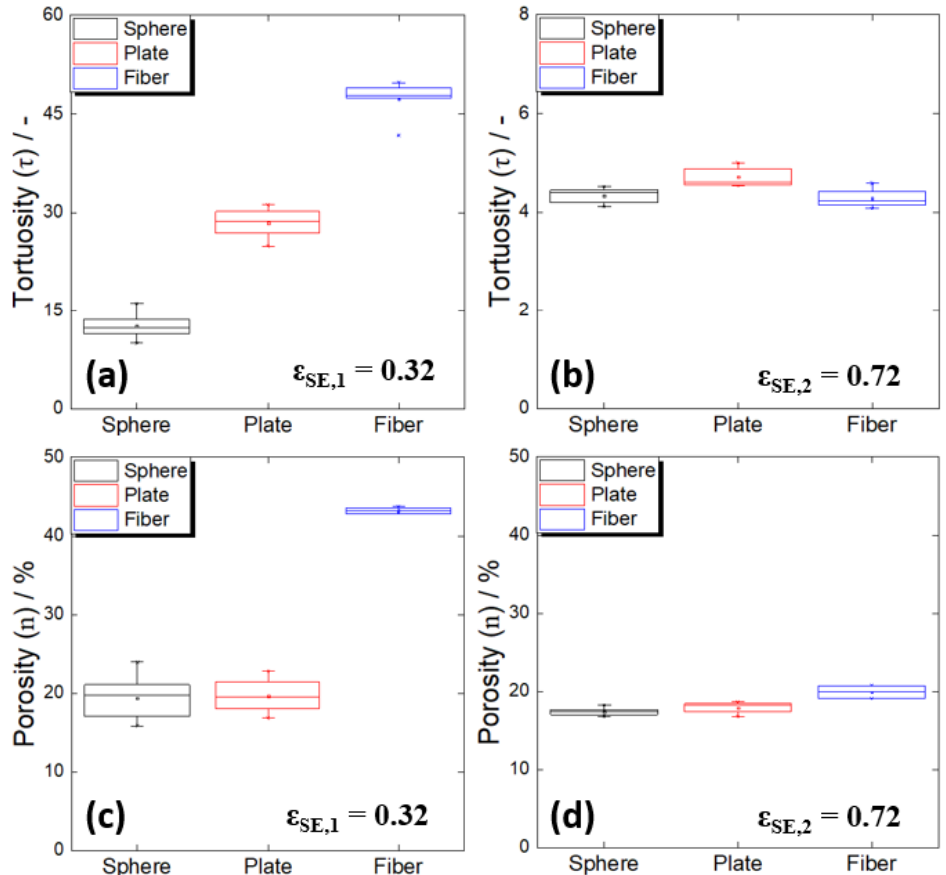
Figure 4. ( a , b ) Tortuosities and ( c , d ) porosities of the composite electrodes containing different shapes of Al 2 O 3 powders. ( a , b ) Low electrolyte volume fraction ( ε SE,1 = 0.32); ( c , d ) high electrolyte volume fraction (ε SE,2 = 0.72).